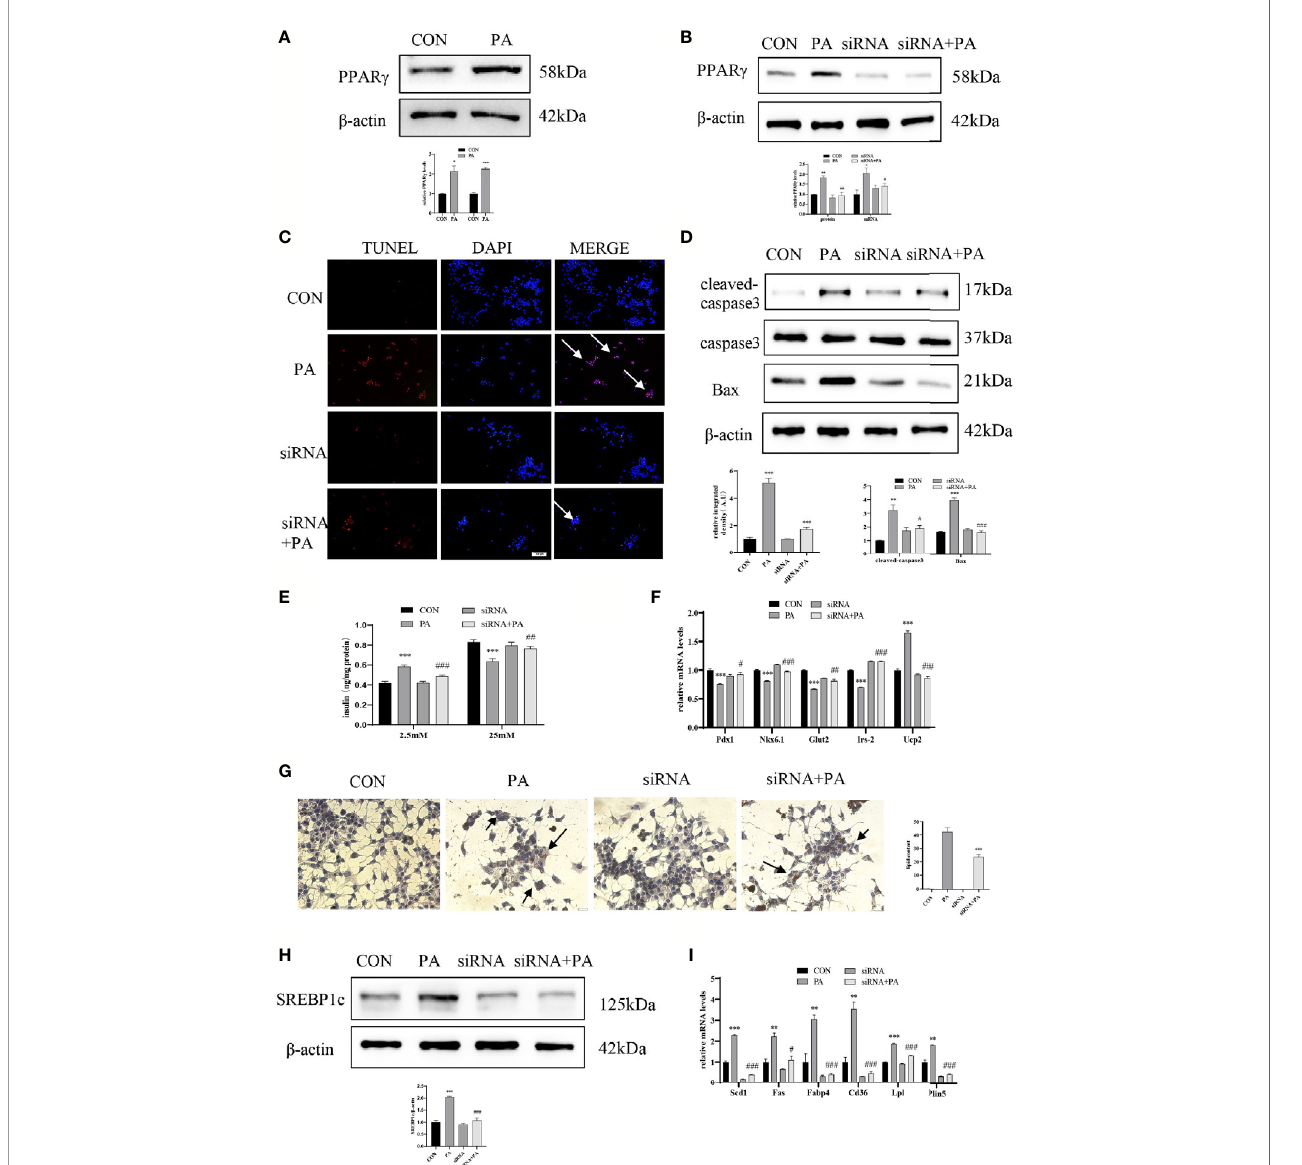
FIGURE 5 | JunD/PPAR g signaling pathway involved in PA-induced INS-1 cells dysfunction. INS-1 cells were transfected with JunD siRNA 470 followed by treatment with 0.4 mmol/L PA for 24 hours. (A, B) Expressions of PPAR g in protein and mRNA levels. (C) Apoptosis was assessed by TUNEL assay, scale bar=50 m m. (D) The protein expressions of cleaved-caspase3 and Bax were detected by Western blot. (E) GSIS was performed to show the dysfunction of insulin secretion after PA stimulation. (F) The mRNA expressions of insulin secretion-related genes, including Pdx1, Nkx6.1, Irs-2, Glut2, and Ucp2. (G) Oil Red O staining was performed to detect the intracellular lipid accumulation, scale bar=20 m m. (H) The protein expression of SREBP1c was detected by Western blot. (I) The mRNA levels of TG synthesis, uptake, hydrolysis, and storage-related genes, including Fas, Scd1, Cd36, Fabp4, Lpl, and Plin5. Data are expressed as the mean± SEM. *p < 0.05; **p < 0.01; ***p < 0.001 (compared with control group), # p < 0.05, ## p < 0.01, ### p < 0.001 (compared with PA